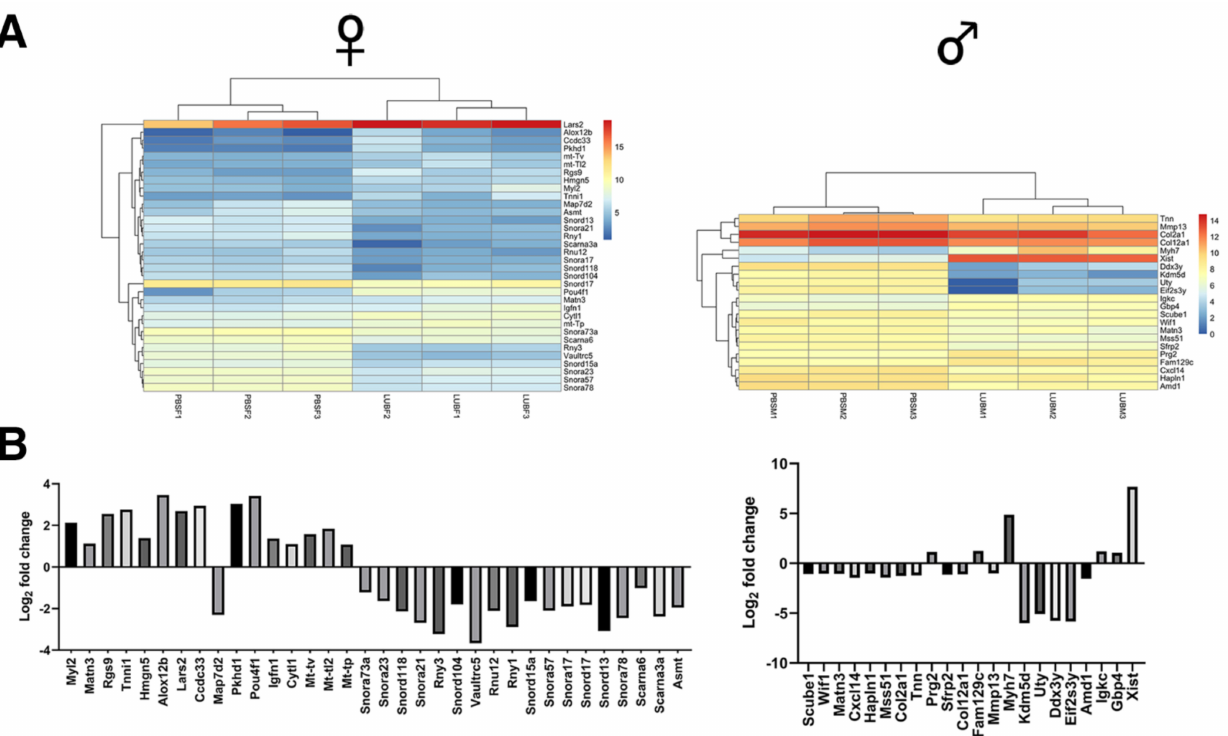
Figure 2. RNA-Seq analysis of chondrocytes recovered from individual male and female Prg4 − / − mice treated with either rhPRG4 or PBS. ( A ) Bi-clustering heat map of differentially expressed genes assorted by their adjusted p -values for both sexes and ( B ) Log2 fold change in genes in PBS vs. rhPRG4 from RNA-seq data for both sexes. Heatmap colors represent the log2 expression values of each group for each gene. Groups were clustered based upon their similar expression values and presented as dendrograms. In total, 34 and 22 known significantly differentially expressed genes were identified in female and male Prg4 − / − mice,